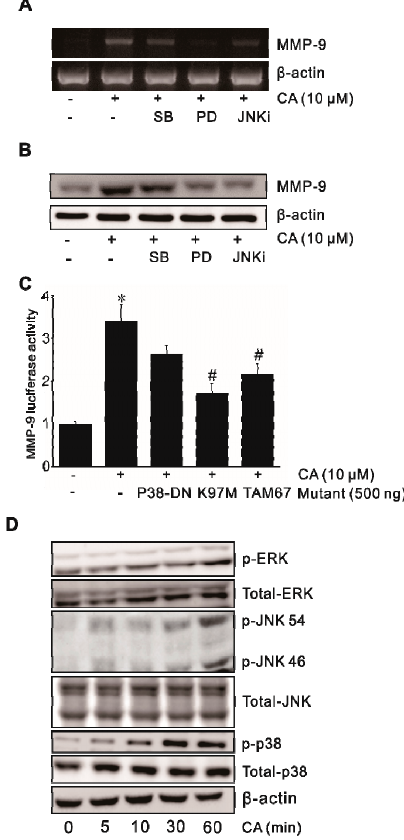
Figure 3. Involvement of MAPK in CA-induced MMP-9 expression. SW620 cells pretreated with 30 µ M SB-203580 (SB), 30 µ M PD-98059 (PD), and 30 µ M JNKi for 1 h were incubated with 10 µ M CA for 4 h. Then, MMP-9 mRNA level was measured by RT-PCR ( A ) and protein level was determined by Western blot analysis ( B ). ( C ) SW620 cells were transiently transfected with dominant-negative mutants of MEK-1 (K97 M) or JNK (TAM67), or mutant p38 MAPK (mP38) and co-transfected with PGL4-MMP-9. After incubation with 10 µ M CA for 4 h, the luciferase activity was measured using a luminometer. Data represent the mean ± standard deviation (SD) from triplicate measurements. * p < 0.05 versus control; # p < 0.05 versus CA only. ( D ) SW620 cells were treated with 10 µ M CA for 0–60 min, and cell lysates were analyzed using specific antibodies by Western blot analysis.